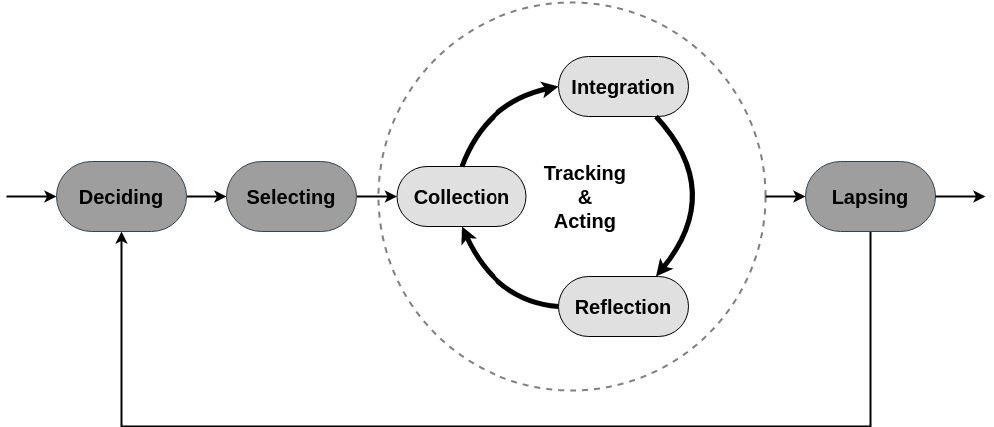
Figure 2. Adapted from Epstein et al.’s lived informatics model of personal informatics: this model is based on Li et al.’s model and highlights the essential fluidity and iteration of a self-quantification process. It is not specifically oriented towards behavior change,